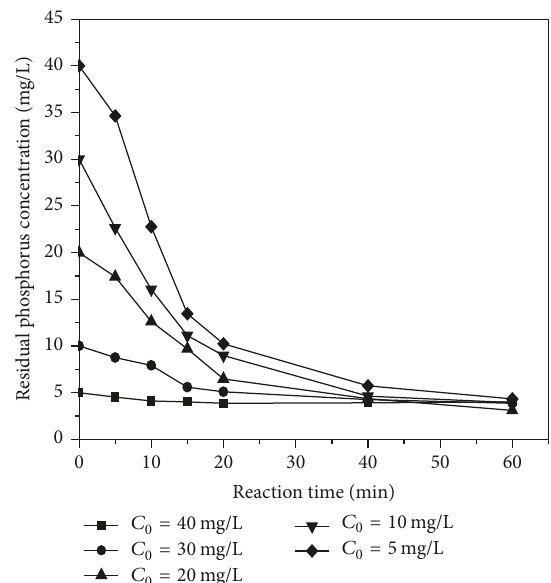
Figure 8: The effect of initial concentration of phosphorus on operation efficiency (initial pH, 7.0; P-CSHs-PEG2000 dosage, 1.0 g/L; stirring speed, 80